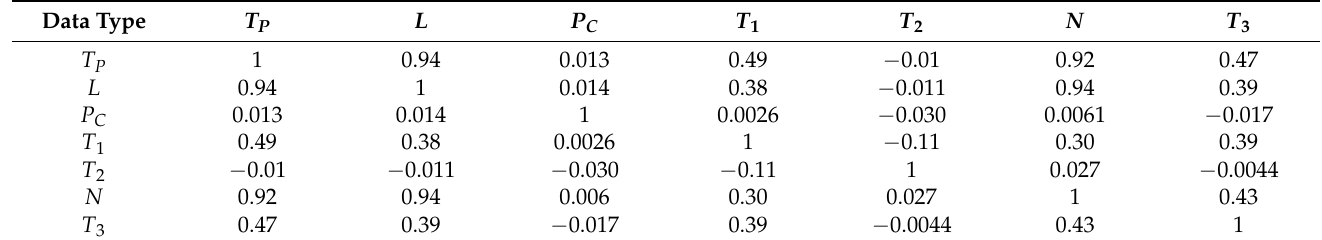
Table 2. Correlation analysis of marine diesel engine operating